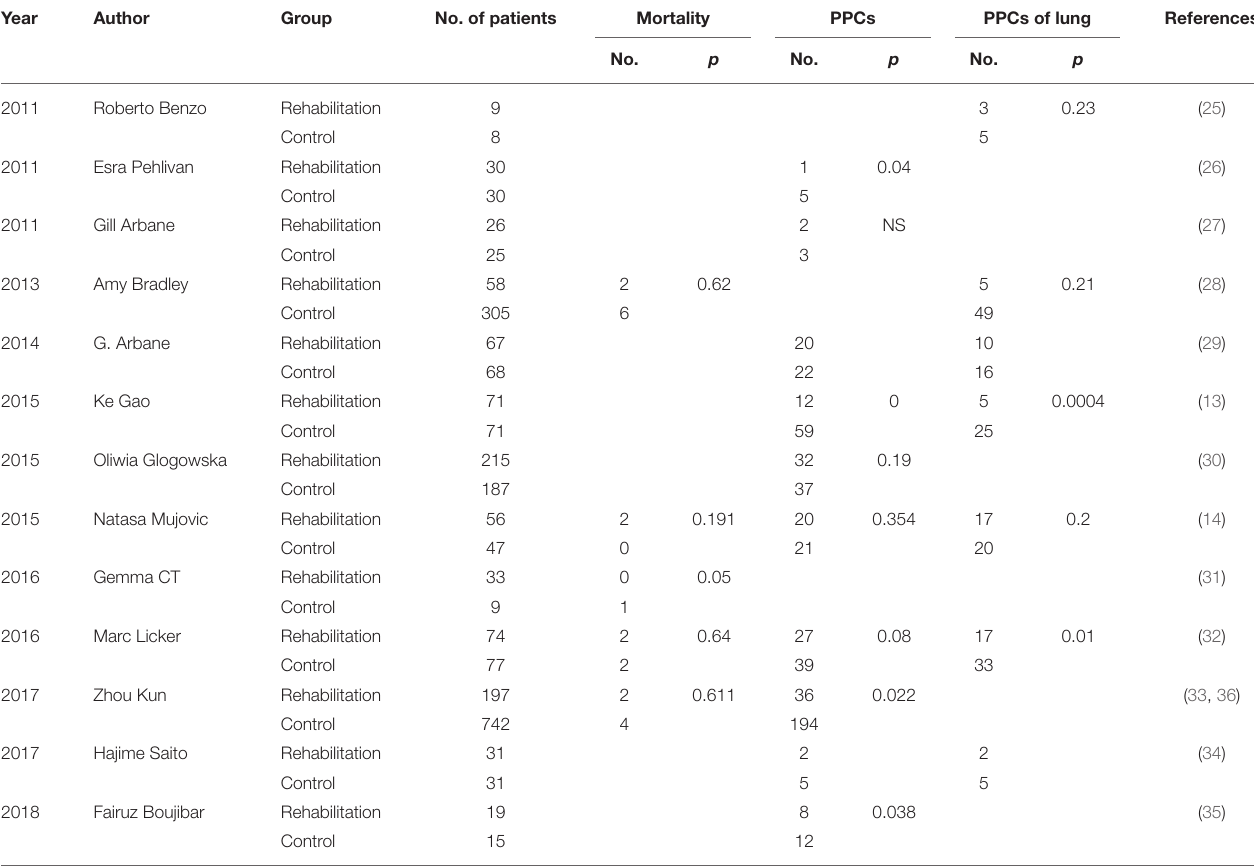
PPCs, post-pulmonary operation